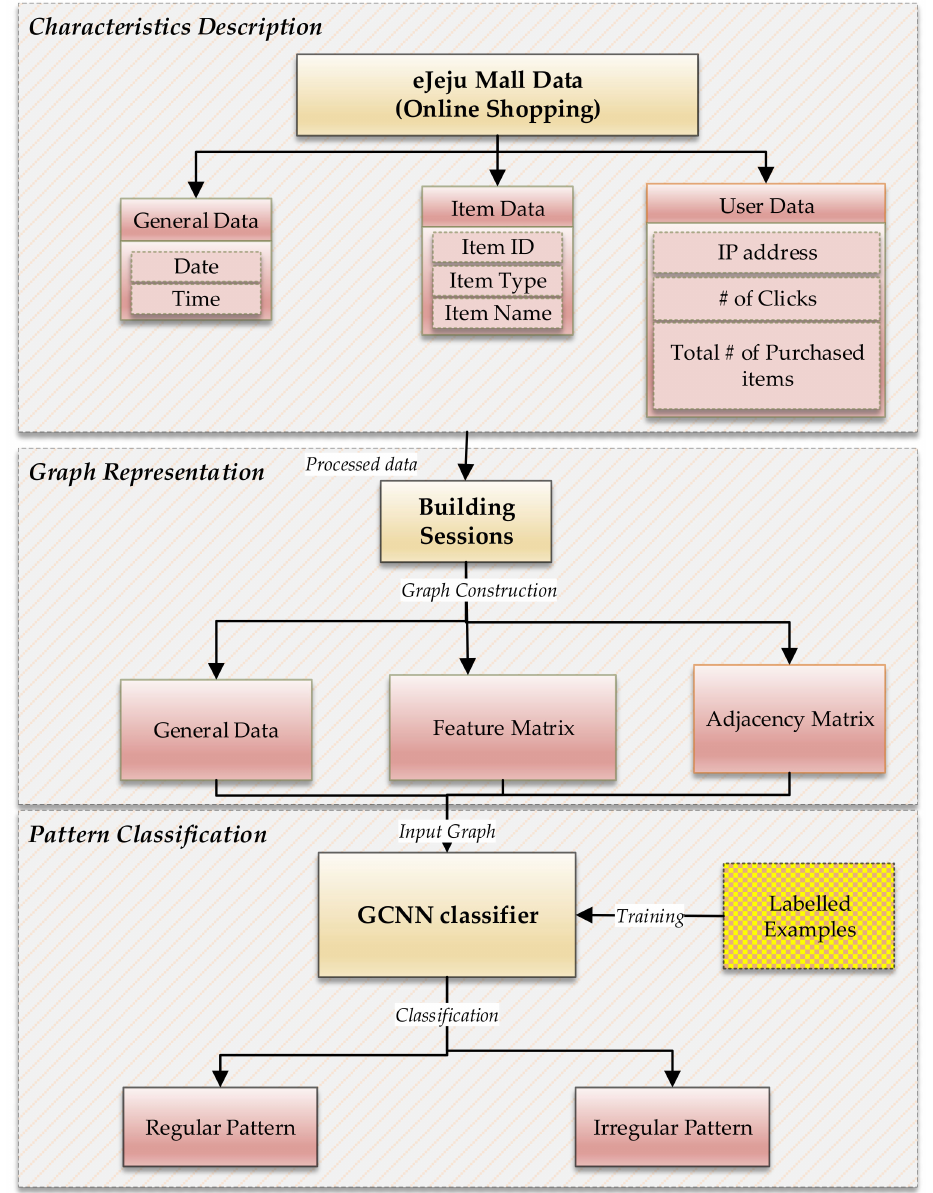
Figure 2. Conceptual framework of the proposed